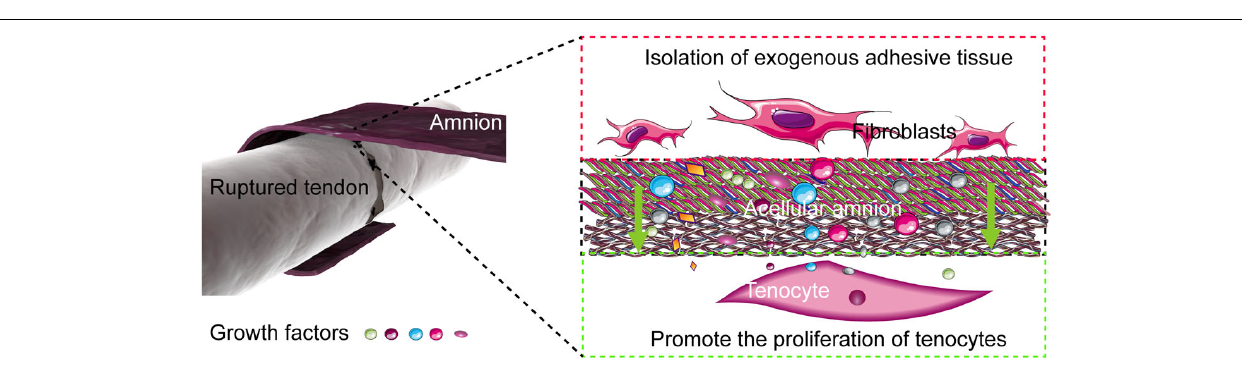
FIGURE 7 | Mechanism of the acellular amniotic membrane that promotes endogenous healing of tendon and prevents exogenous adhesion. The acellular amnion contains several active factors, such as TGF- β 1, bFGF. These factors are released to the tendon repair area, which promotes the proliferation of tenocytes and the synthesis of collagen. The acellular amnion also functions as a barrier to fibroblasts and other exogenous tissue